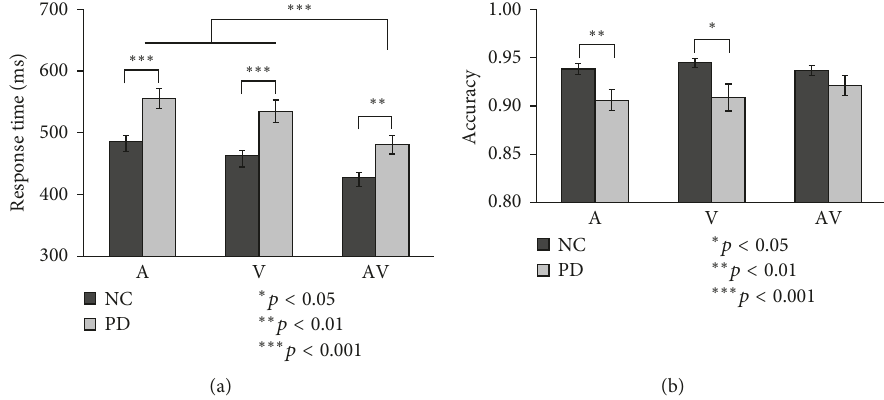
Figure 2: Average reaction times and hit rates by modality and group (error bars indicate the SEM) (A: auditory-only stimulus; V: visual- only stimulus; AV: audiovisual stimulus;